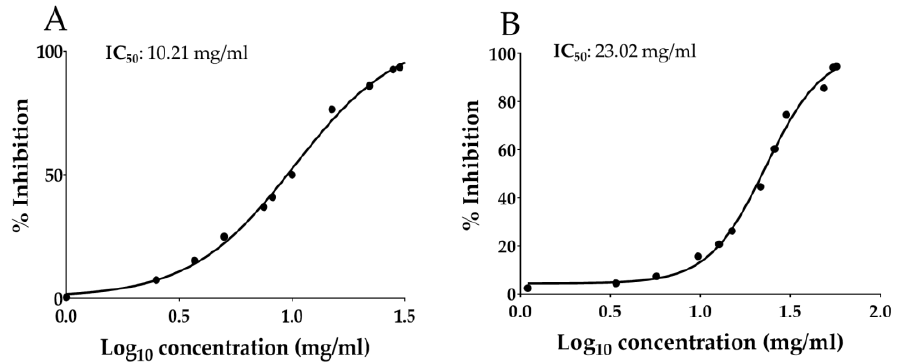
Figure 3. Antiradical activity of Optimized Annurca Apple Oleolyte (OAAO) hydroalcoholic extract expressed as ( A ) IC 50 of DPPH assay and ( B ) IC 50 of ABTS assay. Values represent the mean ± standard deviation of triplicate readings.